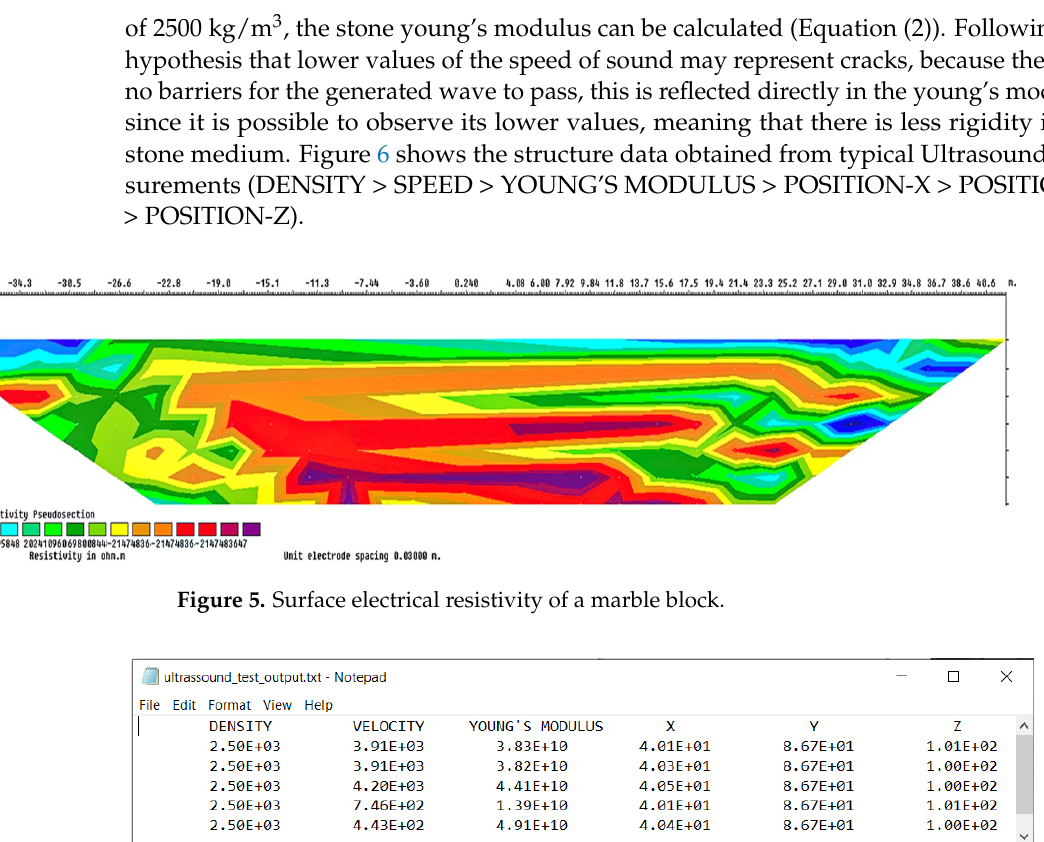
Figure 6. Post-processing data structure from ultrasound tests.